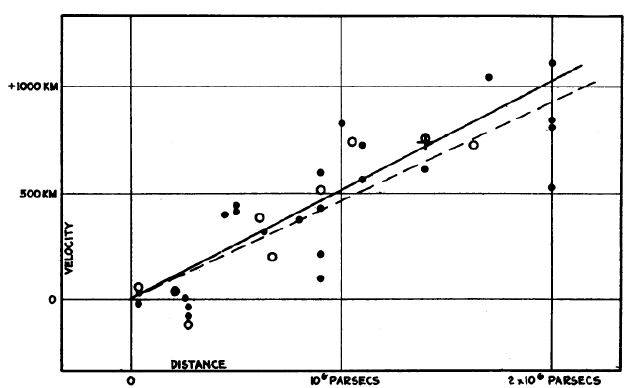
Figure 1: Hubble’s original diagram of distance to nearby galaxies, derived from measurements using Cepheid variables, against velocity, derived from redshift. The Hubble constant is the slope of this relation, and in this diagram is a factor of nearly 10 steeper than currently accepted values. Image reproduced from [95].